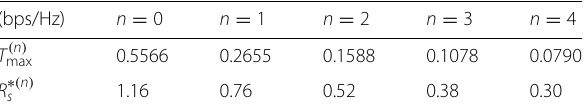
Table 1 Maximum EST and corresponding optimal secrecy rate for each n